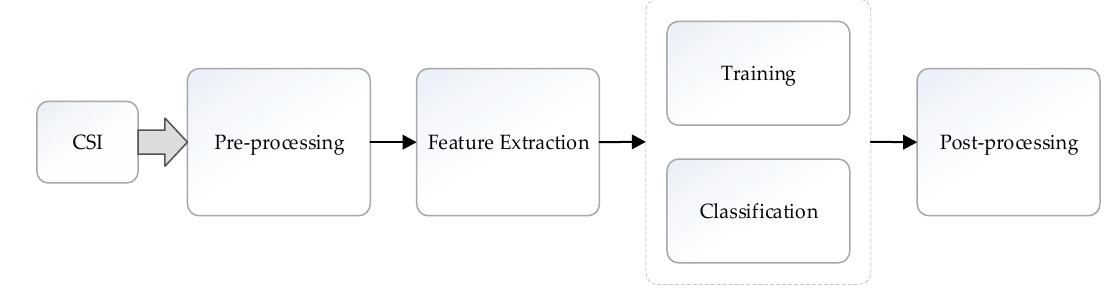
Figure 2. System Framework.